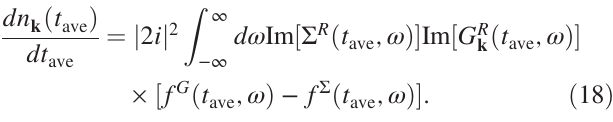
FIG. 9. Top: Population and interaction distribution functions f G ð ω ; t color indicates the temperature obtained from a Fermi function fit. Bottom: cases above